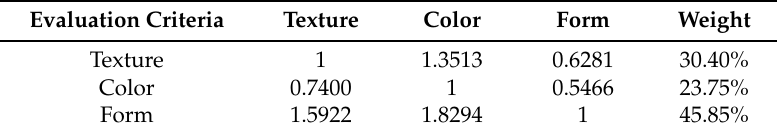
Table 4. Relative importance of assessment factors in hierarchy 2.